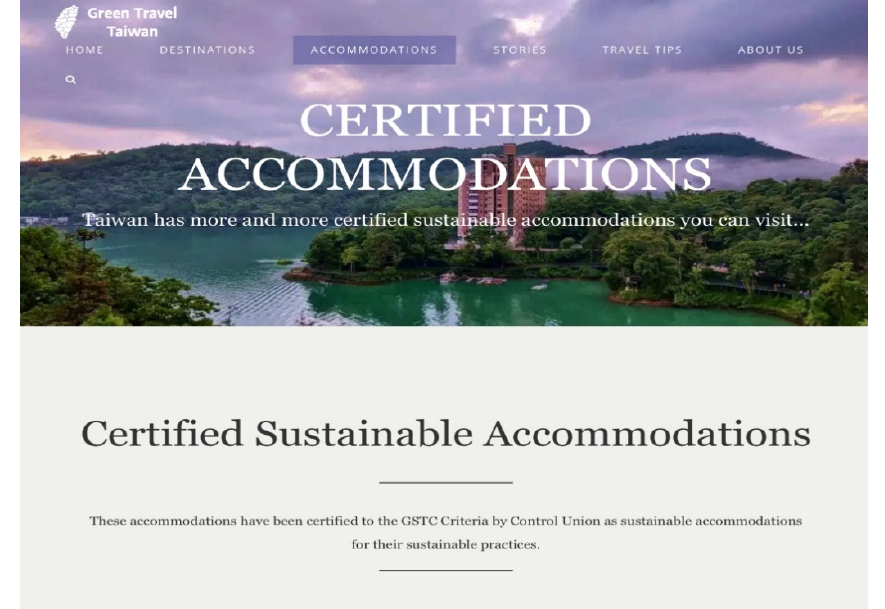
Figure 1. Green Hotel OTA website in Taiwan.